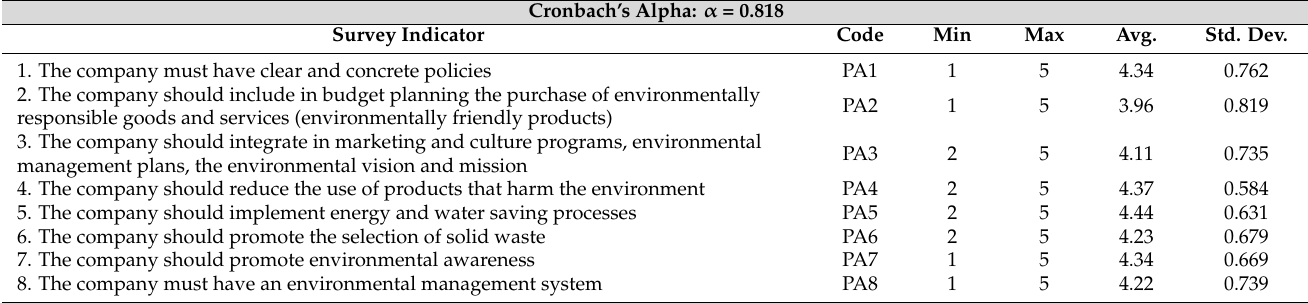
Table 3. Descriptive Statistics of “Environmental Responsibility Practices” survey indicators.